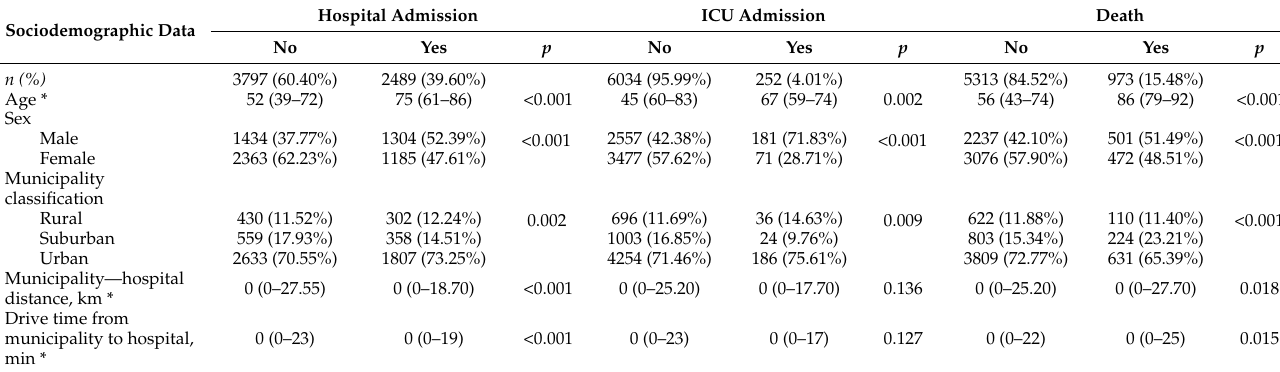
Table 1. Sociodemographic data and previous comorbidities according to different prognoses. Sociodemographic